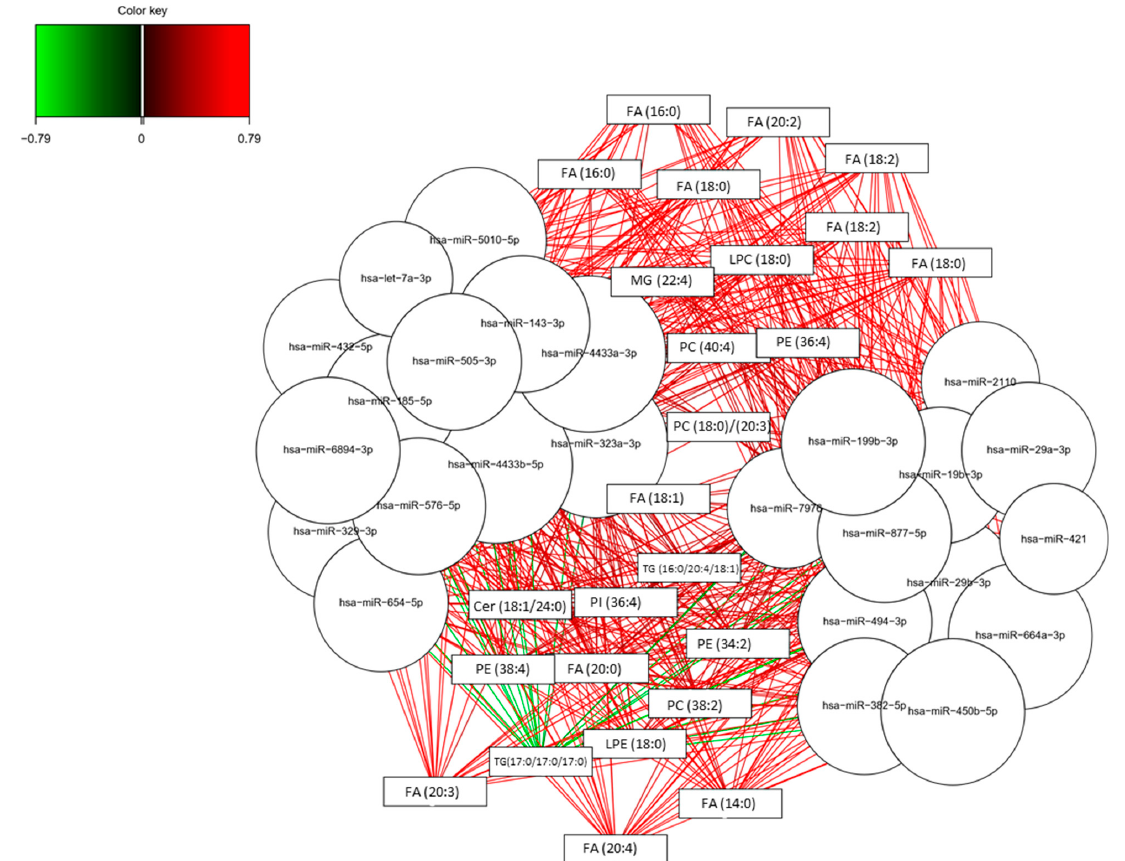
Figure 4. Relevance associations network for sPLS. Pair-wise similarity matrix directly obtained from the latent components was calculated. The similarity value between a pair of variables is obtained by calculating the sum of the correlations between the original variables and each of the latent components of the model. The values in the similarity matrix can be seen as a robust approximation of the Pearson correlation.